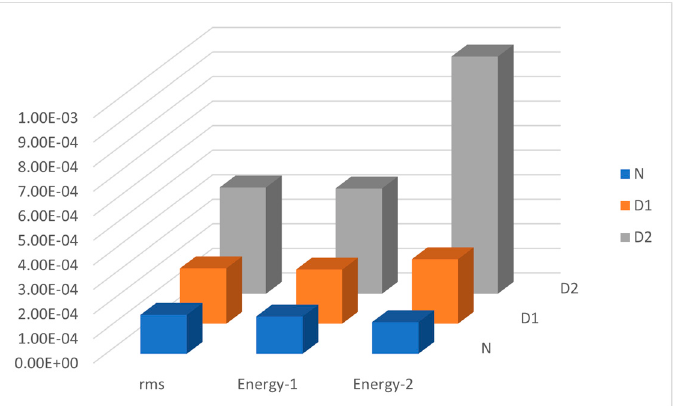
Figure 11. Trend of robust features towards fault severity level (3000 rpm and 9 Nm load).